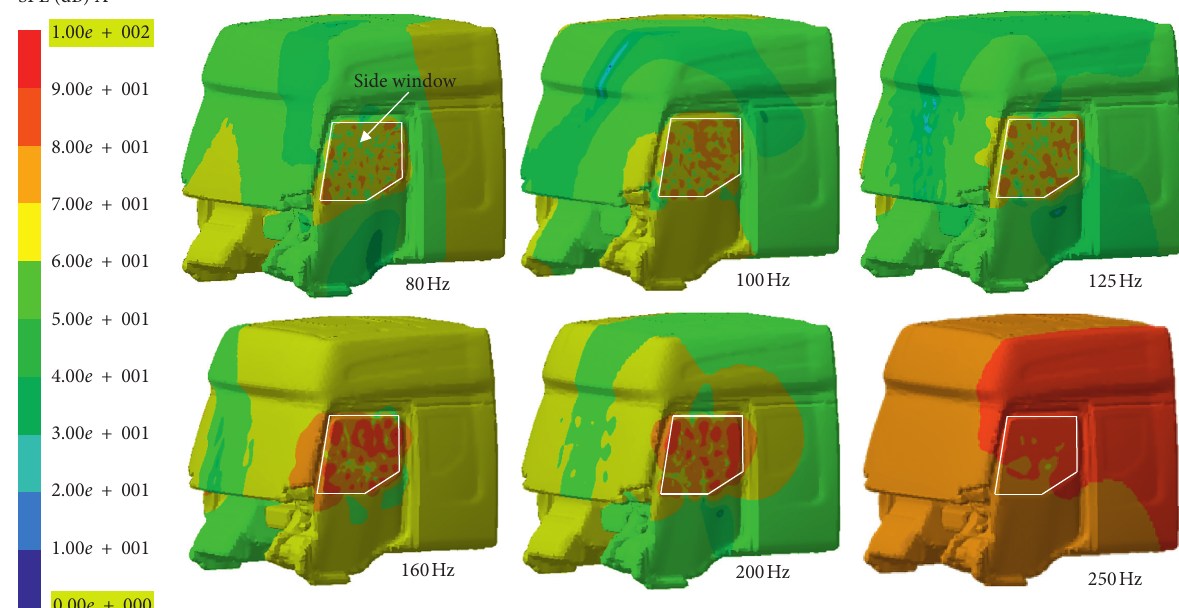
Figure 9: The distribution of the OSRVM A sound pressure level in the cab